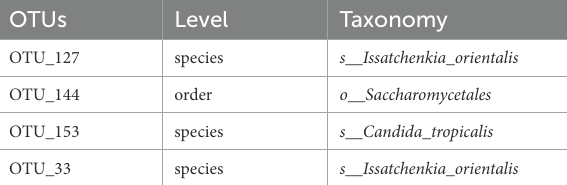
TABLE 7 All gnotobiotic samples core OTUs for ITS1